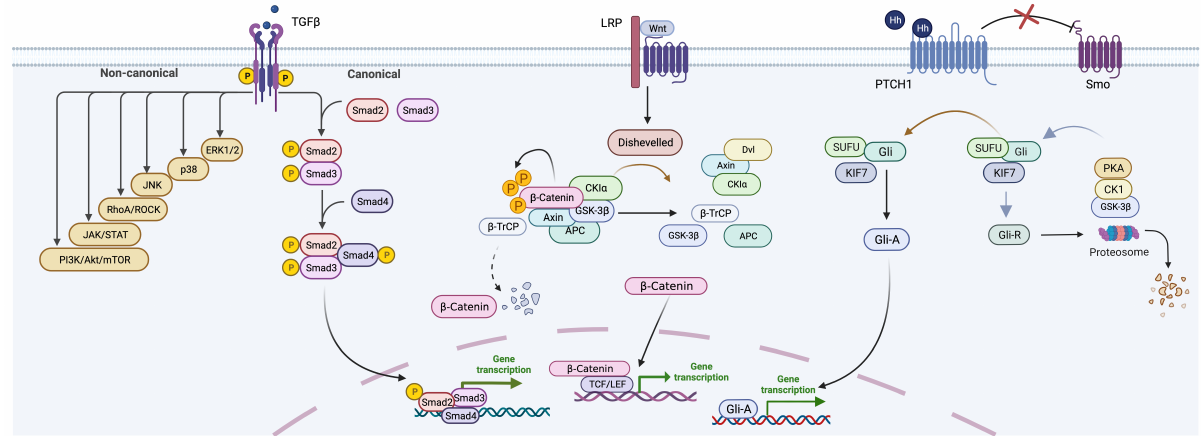
Figure 2. Key signaling pathways in liver